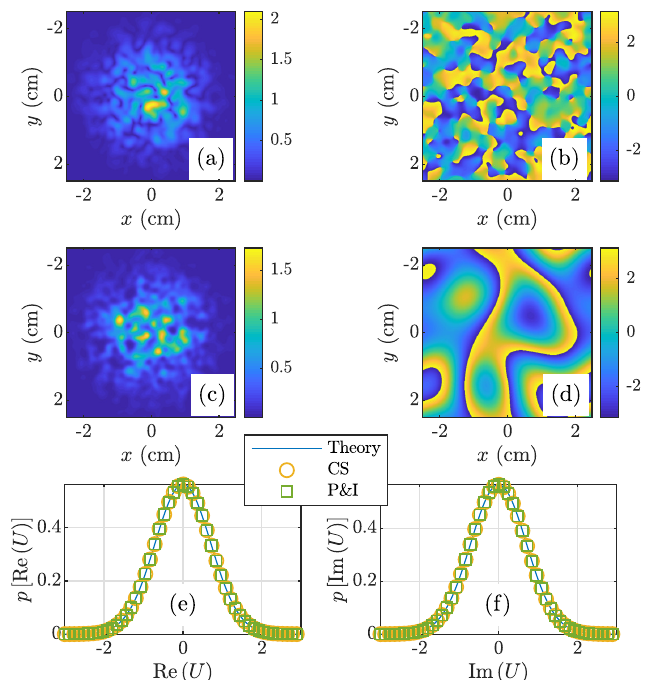
Figure 1. Gaussian Schell-model (GSM) beam field realizations and field probability density functions (PDFs)—( a , b ) complex-screen (CS | U | and arg ( U ) ; ( c , d ) P&I | U | and arg ( U ) ; and ( e , f ) theory, CS, and P&I Re ( U ) and Im ( U ) PDFs. The CS and P&I field expressions are given in Equations (A5) and (2), respectively. The theoretical Re ( U ) and Im ( U ) PDFs are Gaussian with µ = 0 and σ = 1/